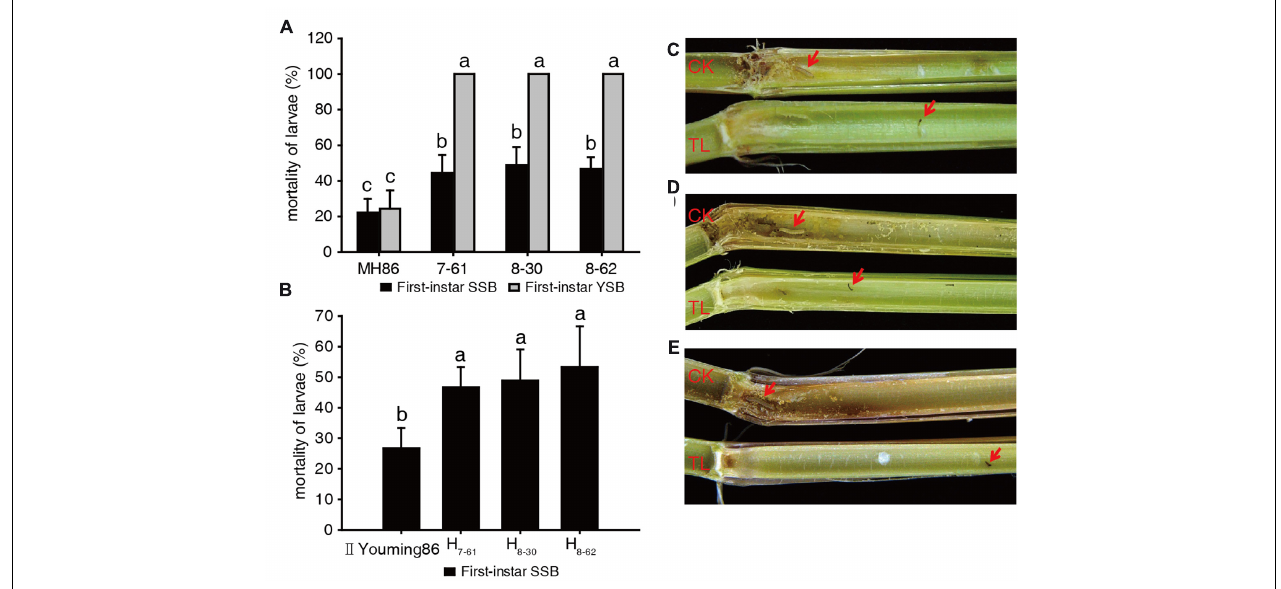
FIGURE 3 | Insect-resistance assay of transgenic materials in the laboratory. Larvae mortality of SSB and YSB fed on three transgenic homozygous lines (A) ; larvae mortality of SSB fed on three transgenic hybrids (B) ; resistance of transgenic homozygous lines against first-instar SSB (C) and YSB (D) ; resistance of transgenic hybrids against first-instar SSB (E) . a, b, c: significant difference at P < 0.05. Error bars indicate SD ( n = 3).